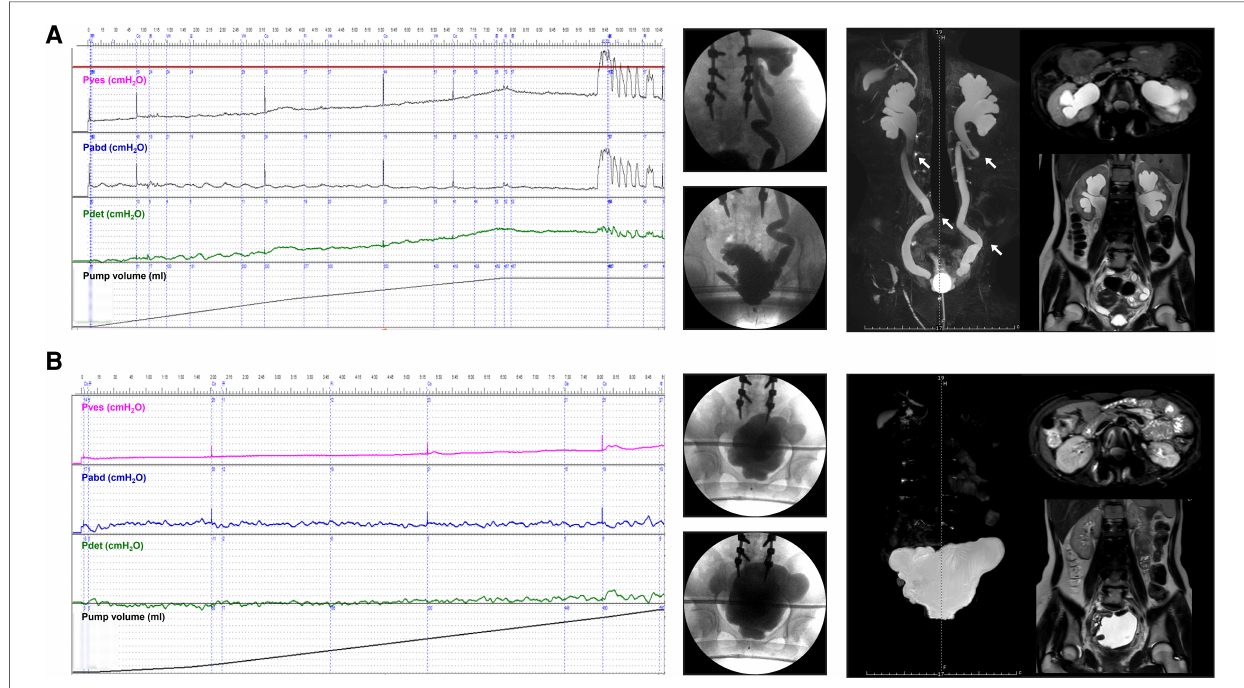
FIGURE 4 Improvement of VUD parameters and UUTD grades in a patient with preoperative roUUTD. ( A ) A 17-year-old girl was admitted to our hospital with urinary frequency and urgency since birth. The serum creatinine was 156.0 μ mol/L, and isotope renography showed a glomerular fi ltration rate of 36.3 ml/min (left) and 42.5 ml/min (right). No decline in the perfusion time-activity curve was observed after administration of diuretics, suggesting the presence of mUUTO. Neither ureter reached 50% activity, and 20-minute residual rates were 84.6% and 94.2%, respectively. VUD showed decreased bladder capacity (79.0 ml) and bladder compliance (10.2 ml/cmH 2 O), with a maximum detrusor pressure of 52.0 cmH 2 O. Left and right VUR were observed at volumes of 79.0 ml (Pdet: 5.0 cmH 2 O, VUR grade: IV) and 262.0 ml (Pdet: 44.0 cmH 2 O, VUR grade: I), respectively. MRU showed a fully dilated renal pelvis, fl uid- fi lled calices throughout the kidney, and tortuous and angulated ureters (Grade 3) that could not be relieved by a preoperative indwelling catheter for suf fi cient bladder drainage. The arrows indicate ureteral stenosis and tortuosity caused by fi brous band formation or peri-ureteral tissue adhesions. All the tortuosity knots or constricting fi brous bands were released, and mobilization of the ureter was con fi rmed by retrograde intubation of a 10 G urinary catheter. The excess terminal ureter was removed, and UARI was performed on the neobladder through a new hiatus and a Kock nipple valve. ( B ) The patient